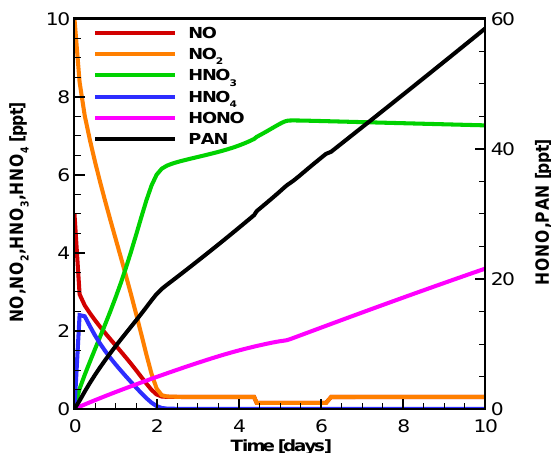
Figure 2. The evolution of nitrogen species under the initial NO